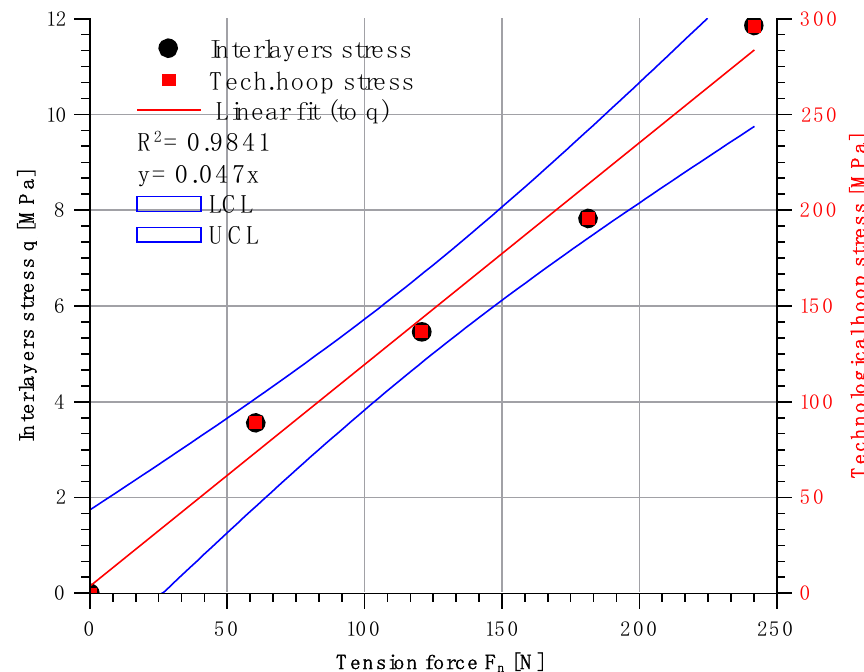
Figure 18. Dependence of interlayer pressure in function of fibre tension force, where LCL—lower control limit, UCL—upper control